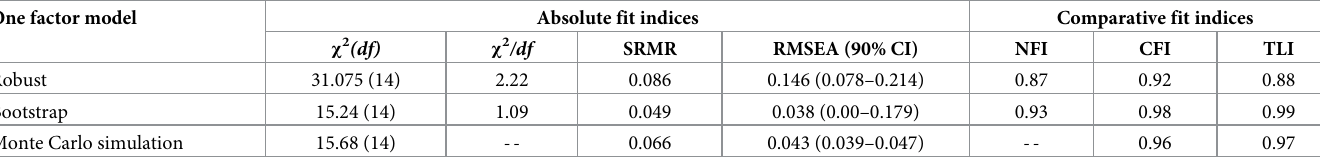
Table 4. Fitting statistics for the one factor model for all of the debriefings (N = 57). One factor